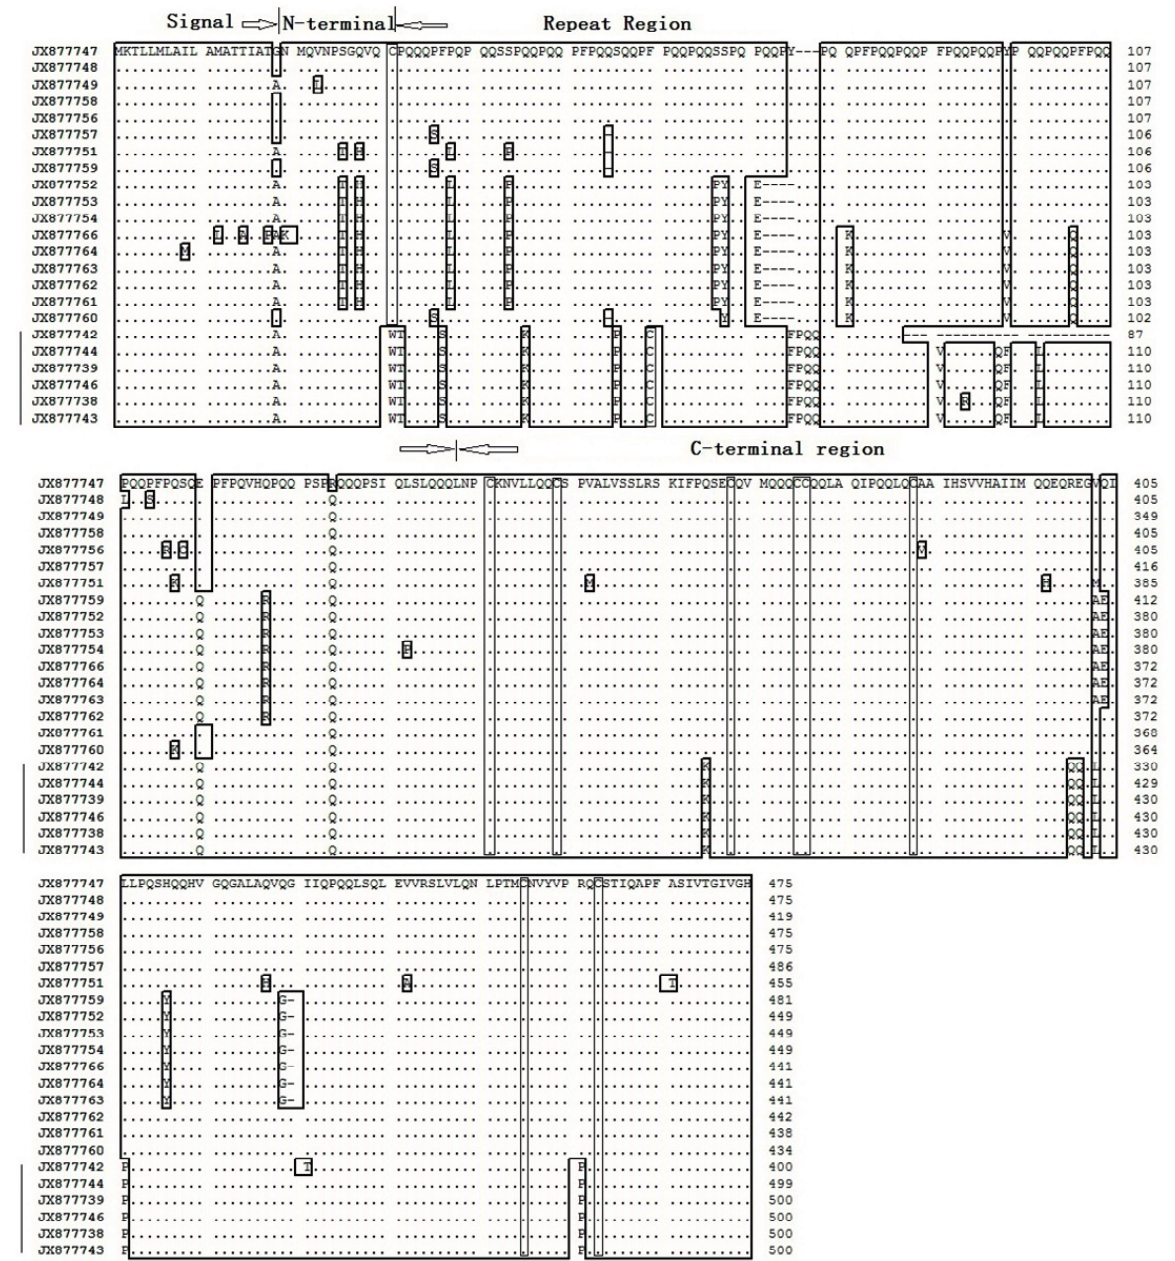
Figure 3. Alignment of deduced amino acid sequence N - and C -terminal regions of S africanum Sec2 and S. sylvestre Sec2 . The cysteine residues are boxed. S. sylvestre Sec2 is marked by a left line